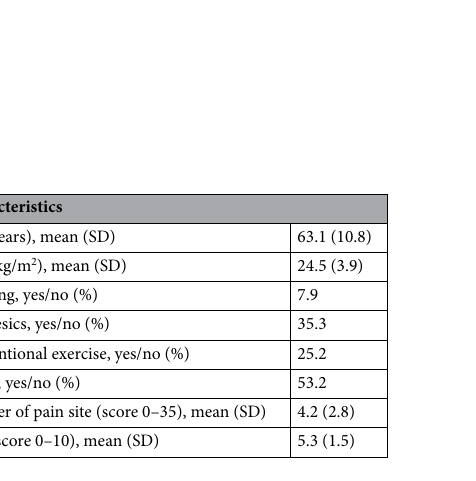
Table 1. Participant baseline characteristics (n = 139). BMI: body mass index; NRS: numeric rating scale; SD: standard